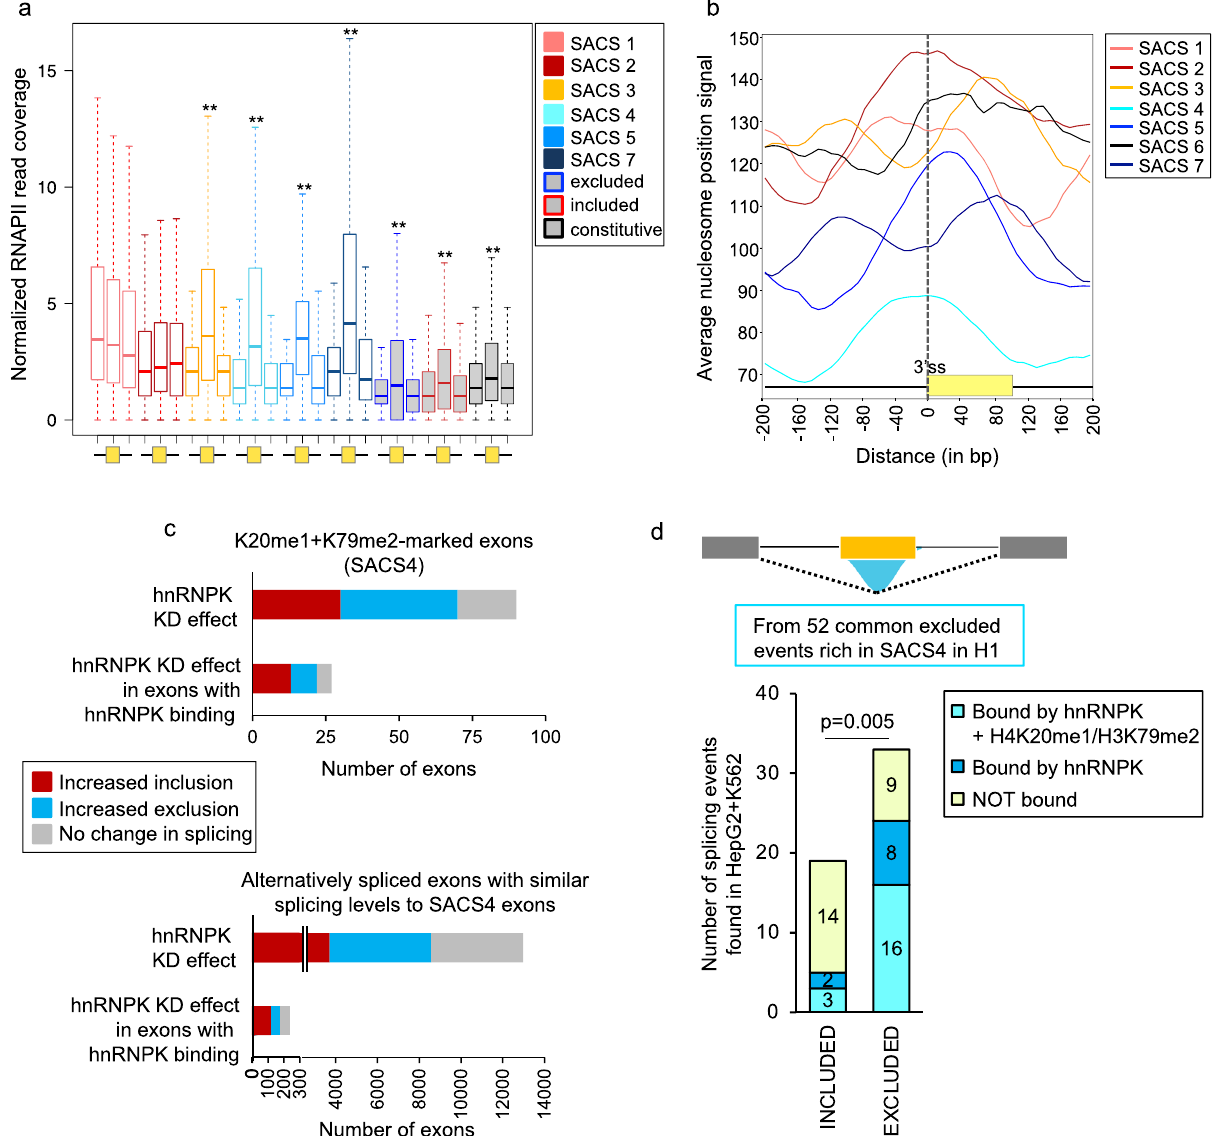
Fig. 7 SACS can impact RNA polymerase II distribution and recruitment of splicing factors. a Box plot centred on the median with interquartile ranges of the normalised RNA polymerase II (RNAPII) reads coverage over the upstream intron, exon and downstream intron for the chromatin-marked exons. Constitutive and non-marked excluded and included exons are used as controls (shaded in grey). RNA polymerase II is more enriched at exons than